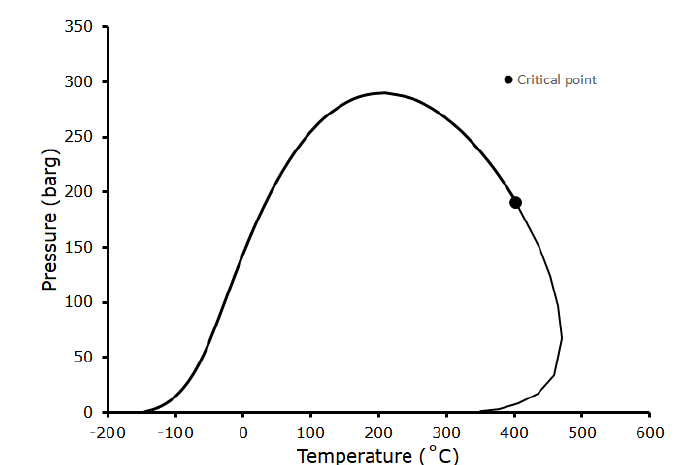
Figure 2. Phase envelopes for the applied well fluid.